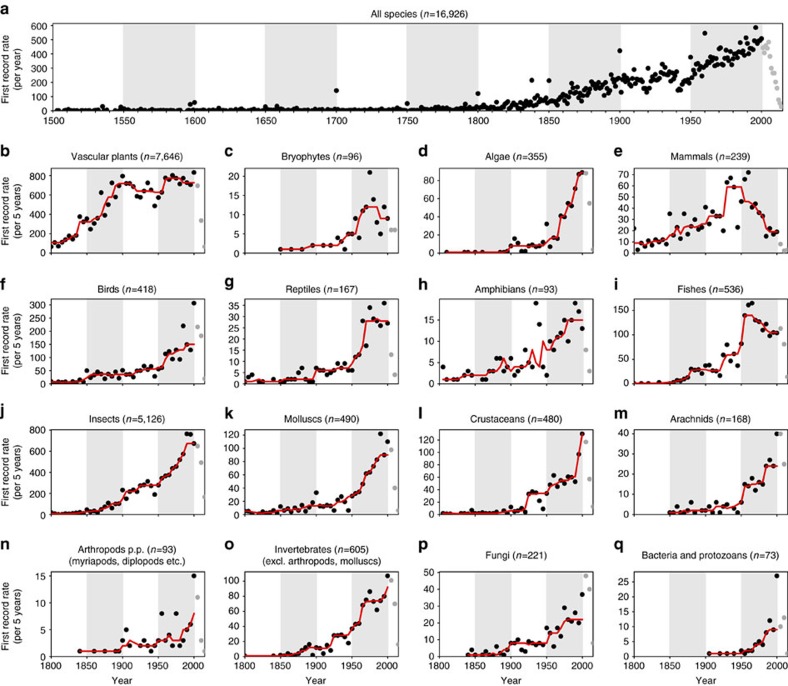
Global temporal trends in first record rates.Global temporal trends in first record rates (dots) for all species (a) and taxonomic groups (b–q) with the total number of established alien species during the respective time periods given in parentheses. Data after 2000 (grey dots) are incomplete because of the delay between sampling and publication, and therefore not included in the analysis. As first record rates were recorded on a regional scale, species may be included multiple times in one plot. (a) First record rates are the number of first records per year during 1500–2014. (b–q) First record rates constitute the number of first records per 5 years during 1800–2014 for various taxonomic groups. The trend is indicated by a running median with 25-year moving window (red line). For visualization, 50-year periods are distinguished by white/grey shading.